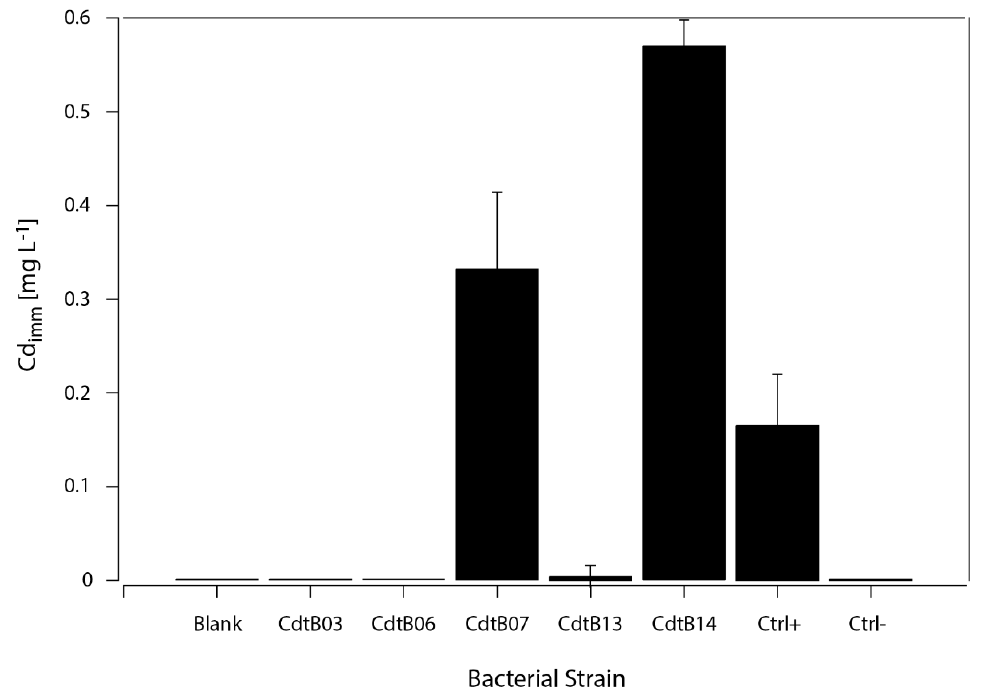
Figure 3. Results of the immobilization test using 6 mg L −1 cadmium chloride (CdCl 2 ). The average difference in Cd after 12 days following incubation of each strain in a solution of 6 mg L −1 CdCl 2 . Cd imm = Cd immobilized ratio after 12 days of incubation. The error bar indicates the standard deviation of the replicates (n = 3). Ctrl+ = positive control ( C. taiwanensis DSM17343) and Ctrl − = negative control ( E. coli K12 DSM 6722).